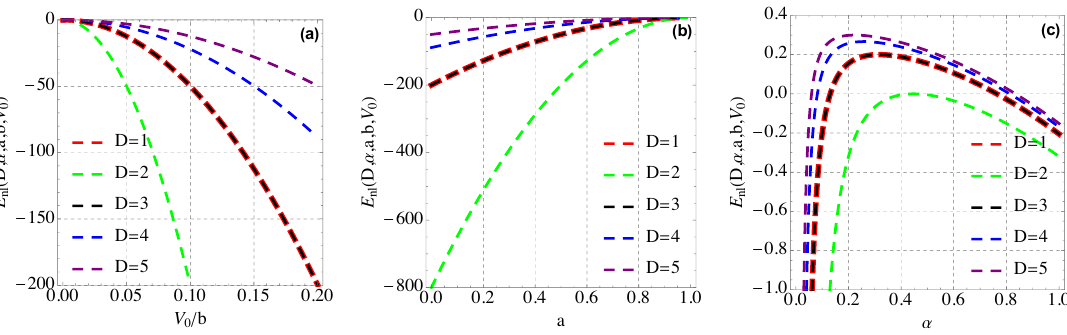
Figure 1. Variation of E nl energy values of the MHP versus ( a ) ratio V 0 / b ( b ) parameter a ( c ) screening parameter α for different values of D , D = 1 (red curve), 2 (green curve), 3 (black curve), 4 (blue curve) and 5 (purple